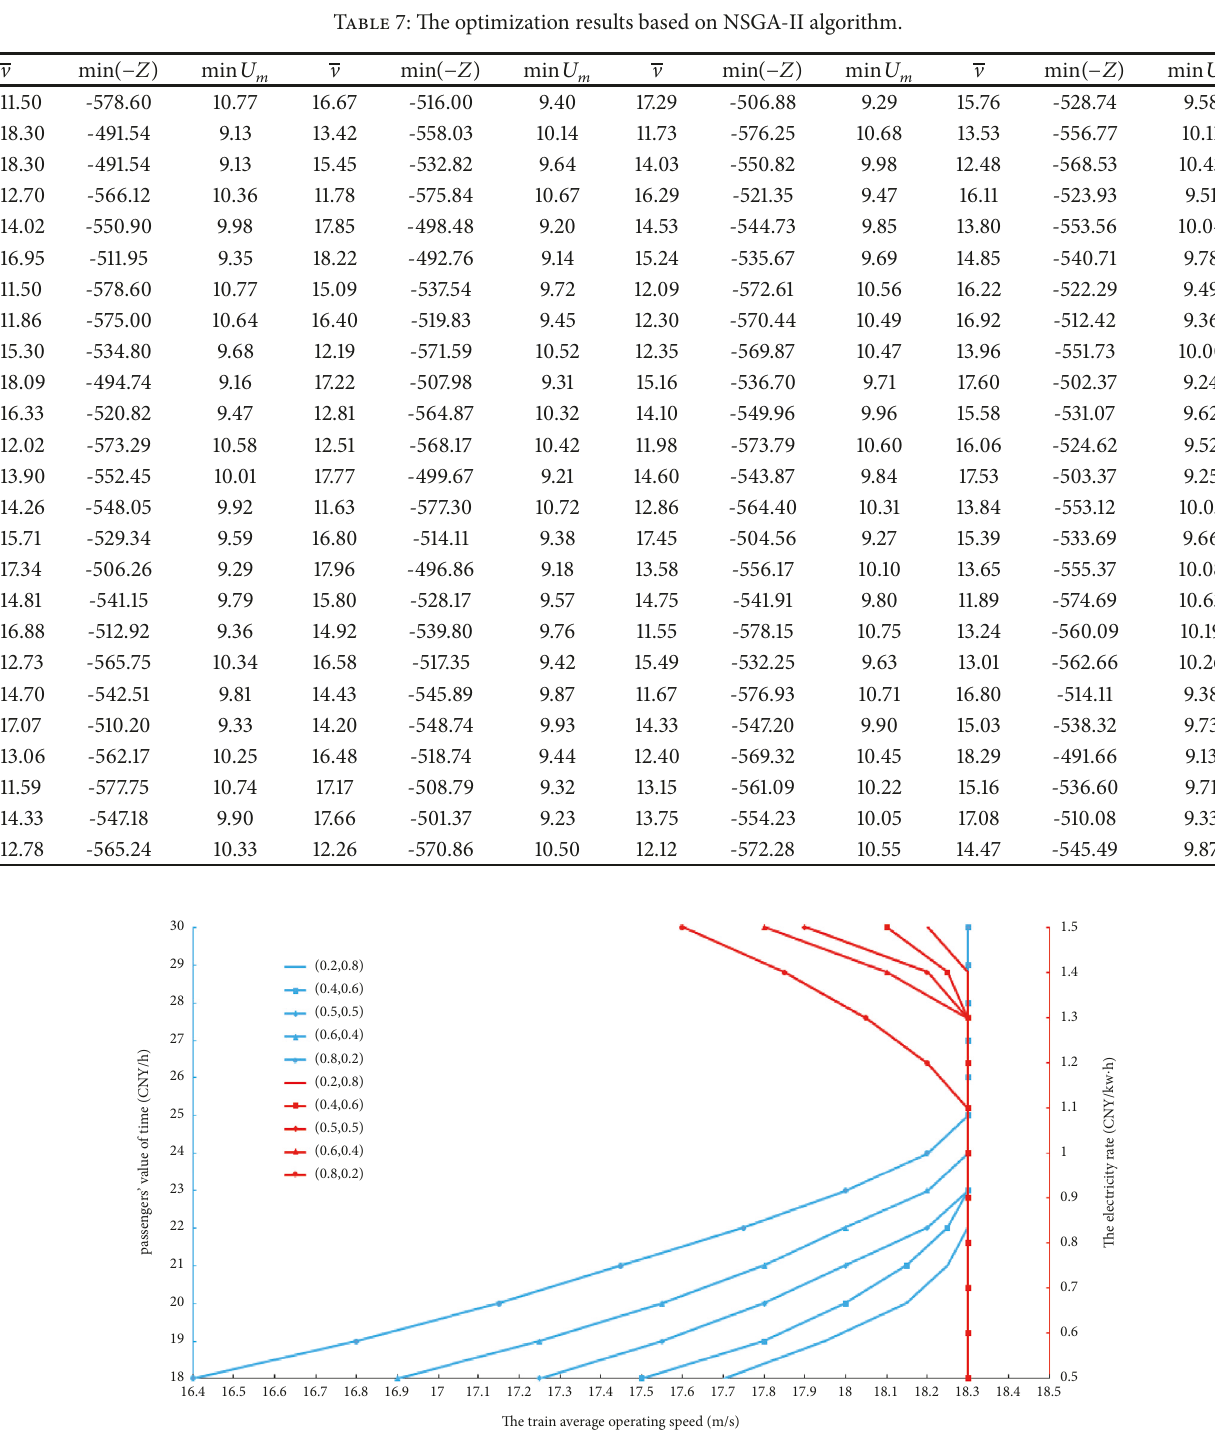
Figure 10: The trade-off between the main parameters and the train average operating speed in the